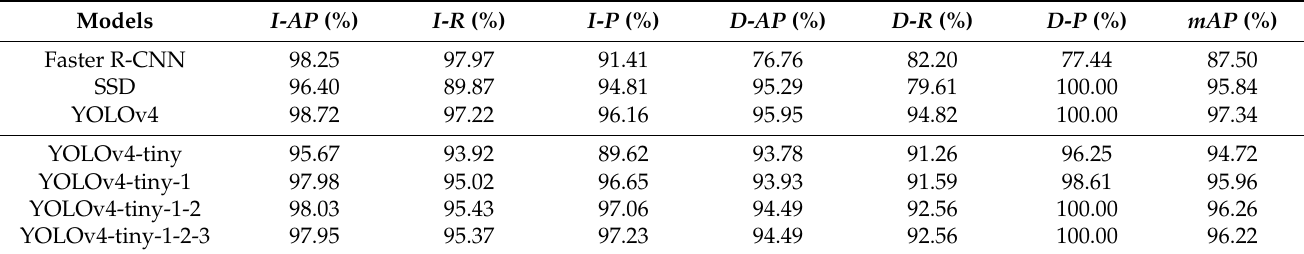
Table 6. Comparison of the model detection